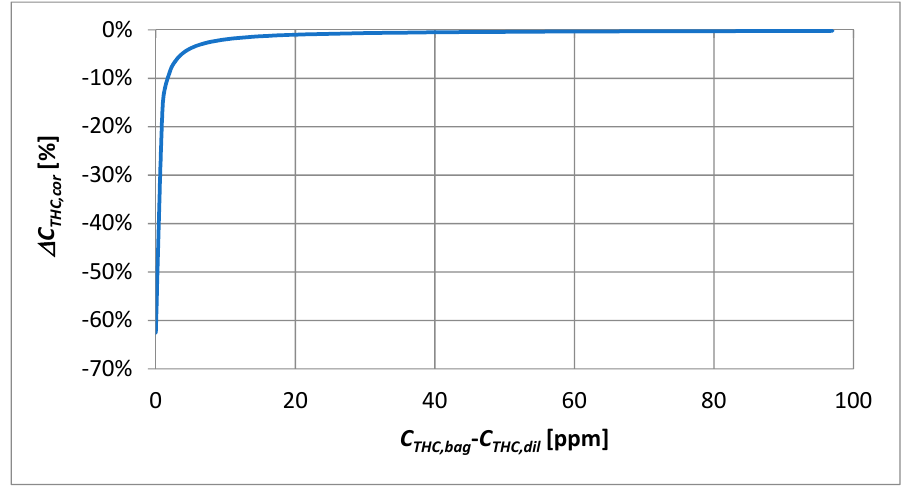
Figure 15. The error of the calculated THC concentration in the diluted exhaust gas, corrected for its content in the dilution air as a function of the difference between the THC concentration in the diluted exhaust gas C THC,bag and the THC concentration in the dilution air C THC,dil .